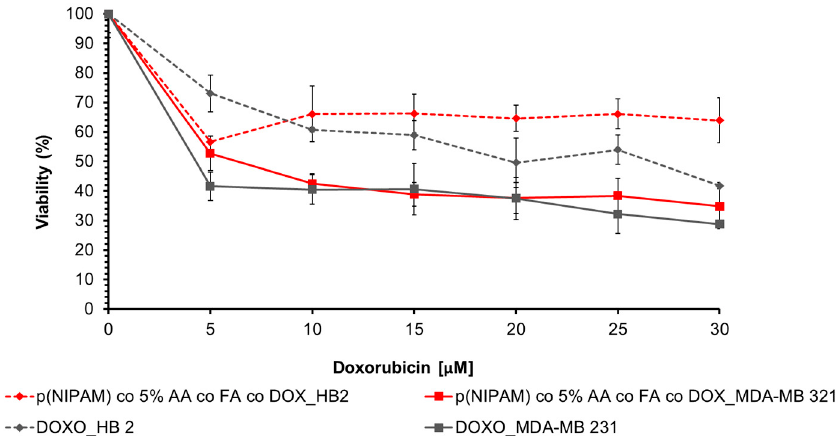
Figure 10. Cell viability assay on HB2 (normal) and MDA-MB 231 (cancer) cells incubated for 24 h with different concentrations of doxorubicin conjugated with p(NIPAM)-co-5%AA-co-FA-co-Dox. Cells incubated with the equivalent concentrations of doxorubicin were used as positive control.